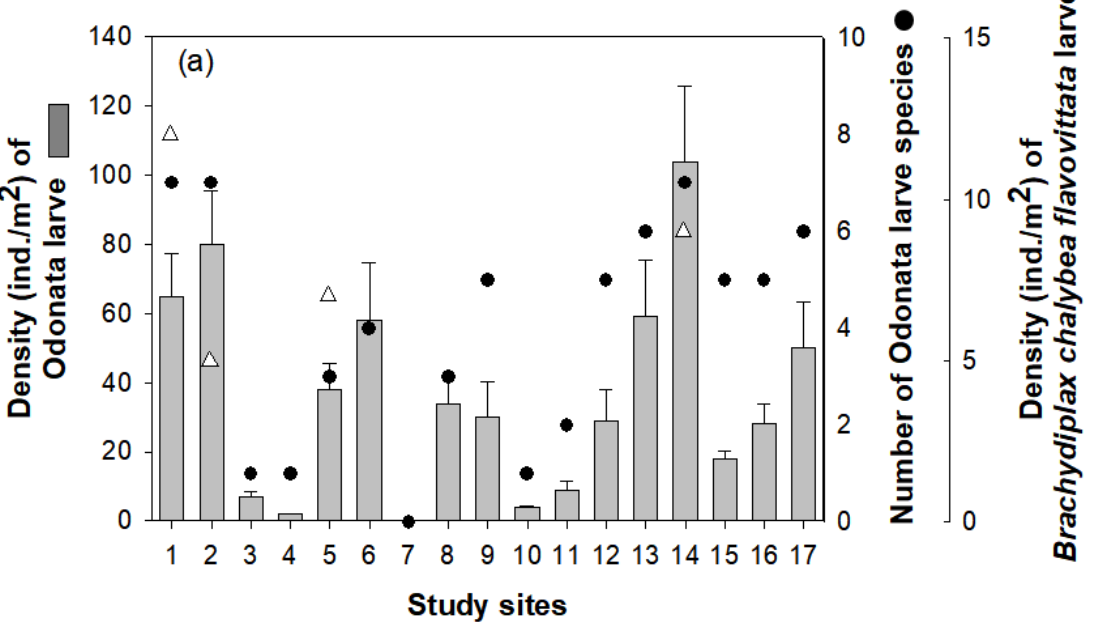
Figure 2. Density and species number (black closed circles) of Odonata larvae in 17 riverine wetlands. Densities of Brachydiplax chalybea flavovittata larvae are indicated by open triangles.